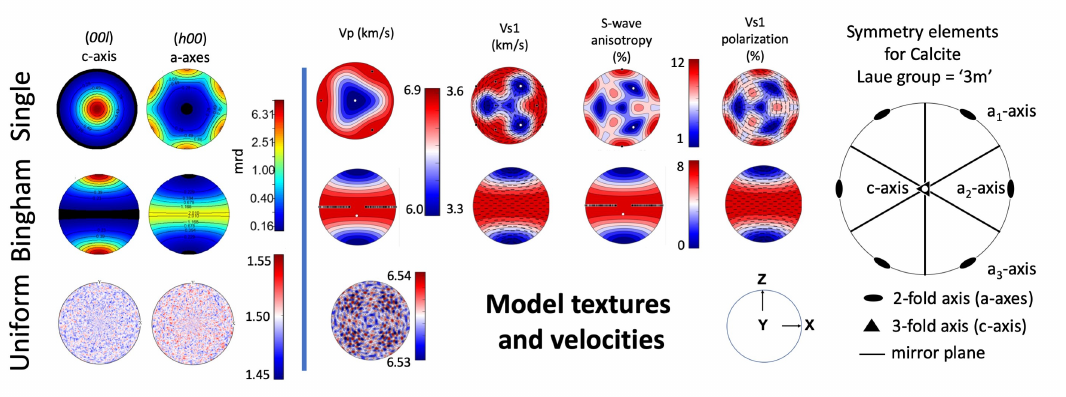
Figure 4. Pole figures for model textures and seismic velocities for single crystal-like, uniform, and bingham textured samples. Symmetry elements are shown for calcite